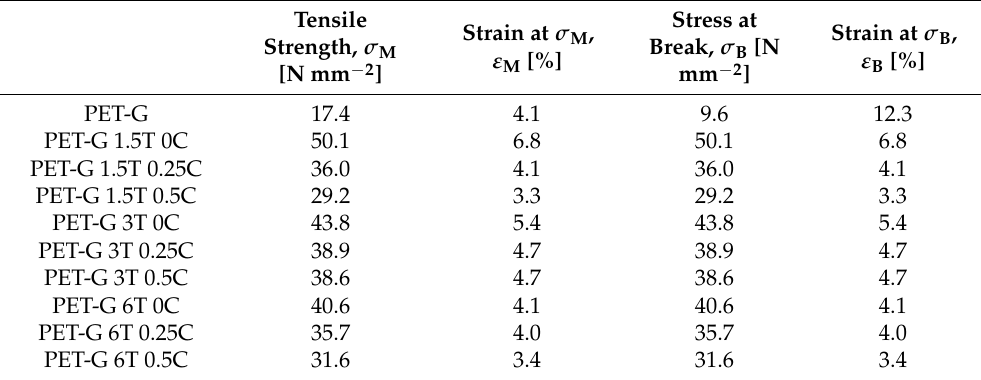
Figure 11. Tensile test results of PET-G and PET-G/6% TiO 2 composites with added CNT ratios .